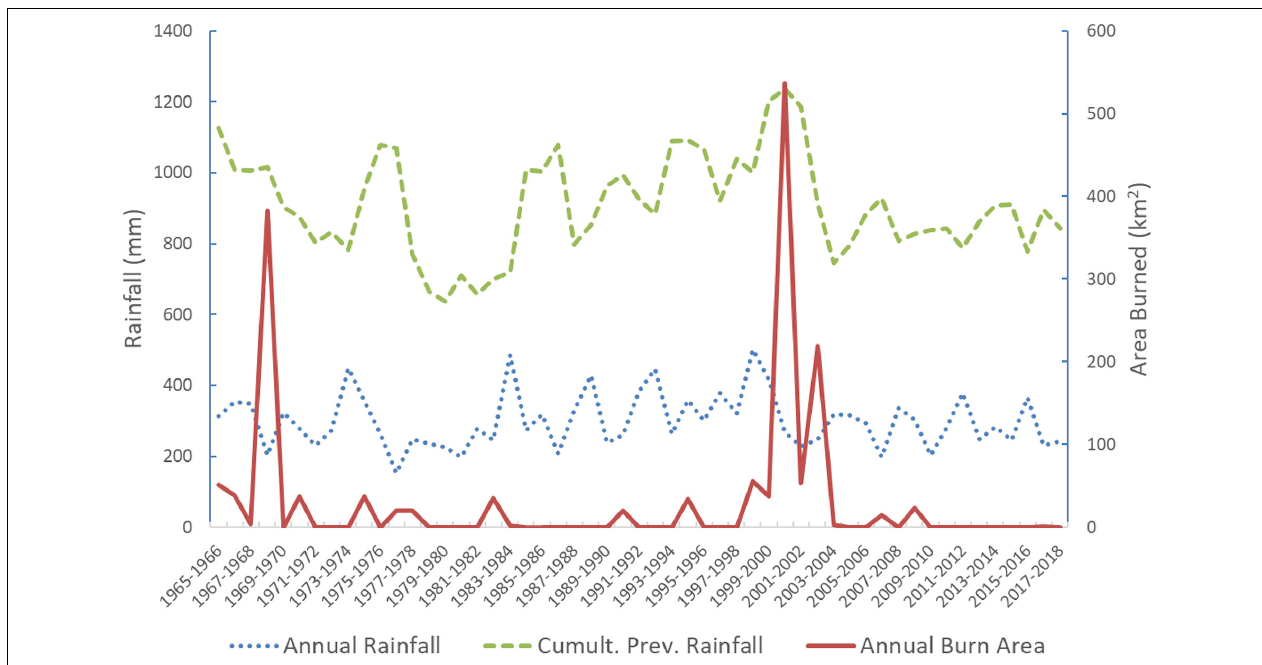
FIGURE 2 | Relationships between annual rainfall, previous 3-year rainfall and burn area (all based on financial year). Both regional average rainfall for each financial year and cumulative 3-year rainfall (total rainfall from 1 to 3 years prior to financial year) are shown. TABLE 3 | Mean distance (m) of 1,000 randomly selected points to the nearest edge of its vegetation type for burnt and unburnt points. Veg/land type Mean distance from edge of vegetation type (s.e.) df t p Unburnt (1960–2018) Burnt